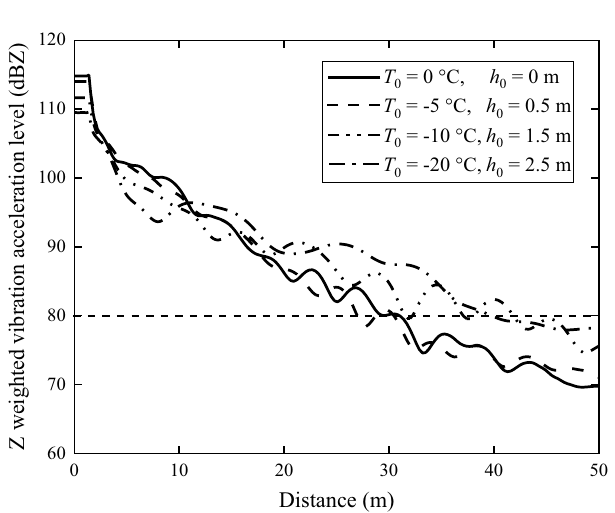
Figure 24. Z-weighted vibration acceleration level along the distance perpendicular to the track